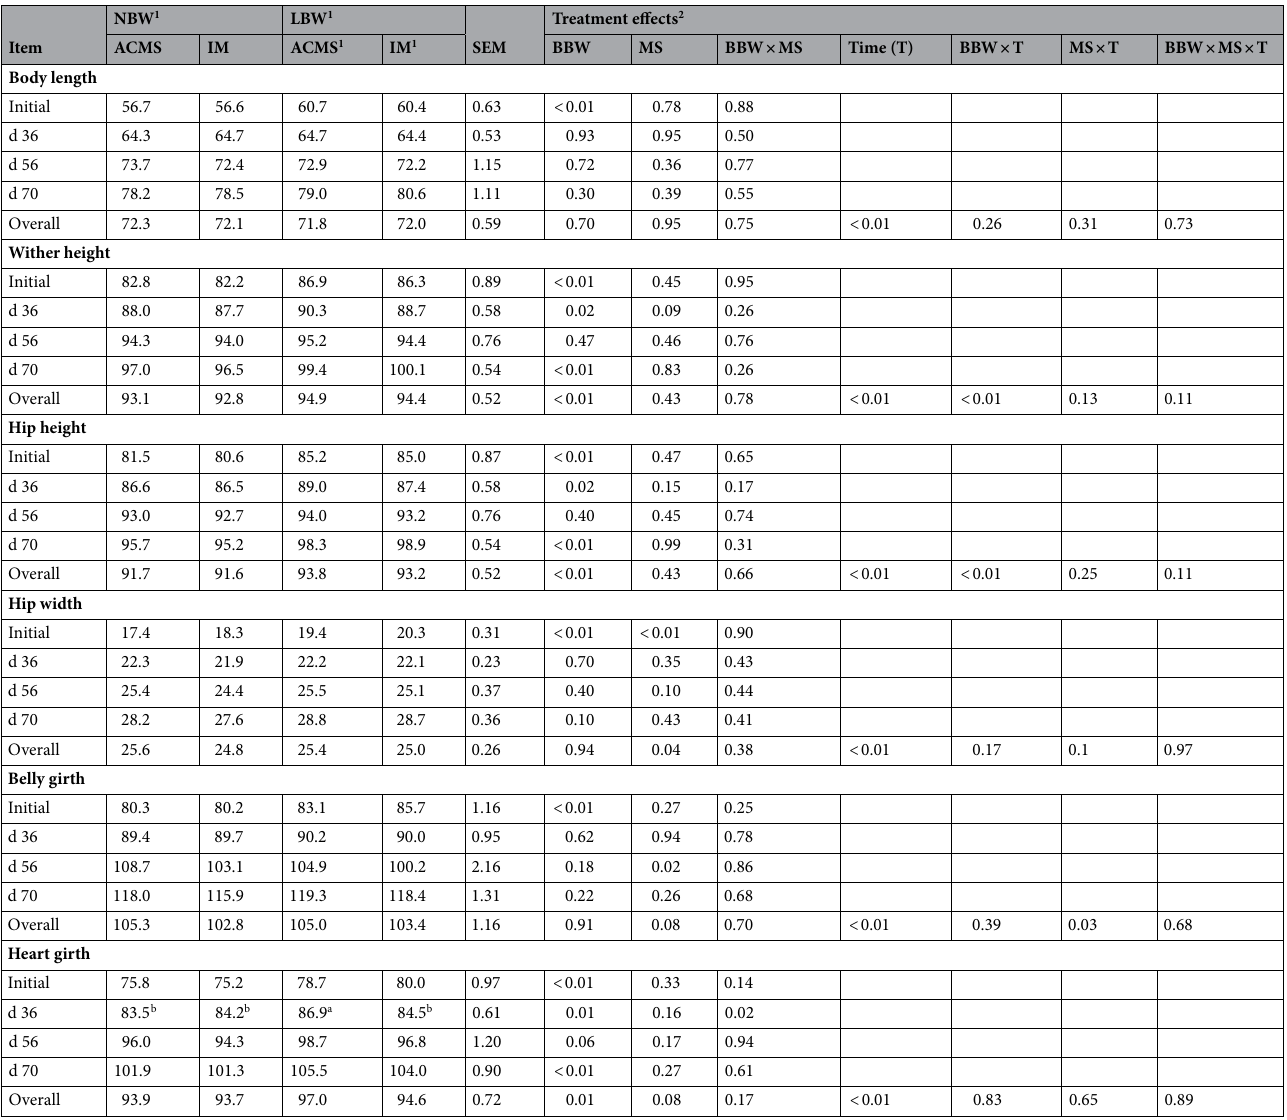
Table 5. Effects of dietary mineral source and birth body weight (BBW) on structural growth (cm) of dairy calves (n = 13 per treatment). 1 IM inorganic minerals source, ACMS advanced chelated mineral source, LBW low birth weight, NBW normal birth weight. 2 Contrasts for BBW (birth body weight), MS (mineral source) and interaction (BBW × MS). a,b,c Means within a row with different superscripts are significantly different ( P <